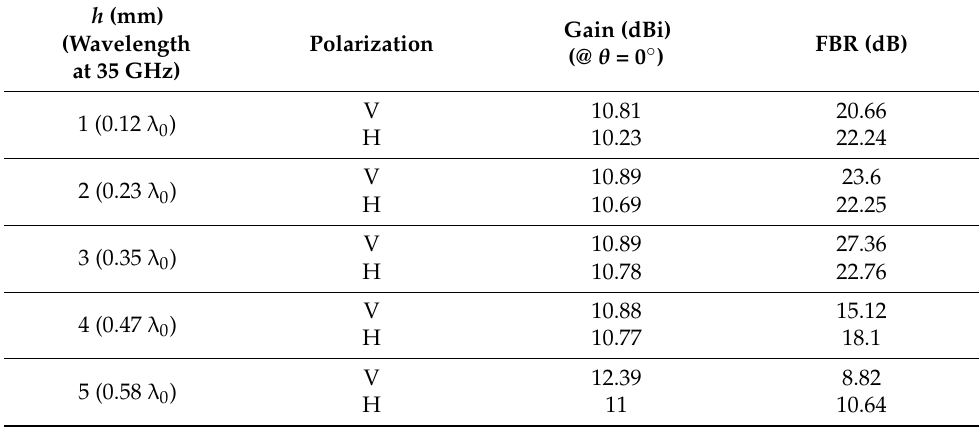
Table 2. Simulated radiation performances for various h values at 35 GHz.